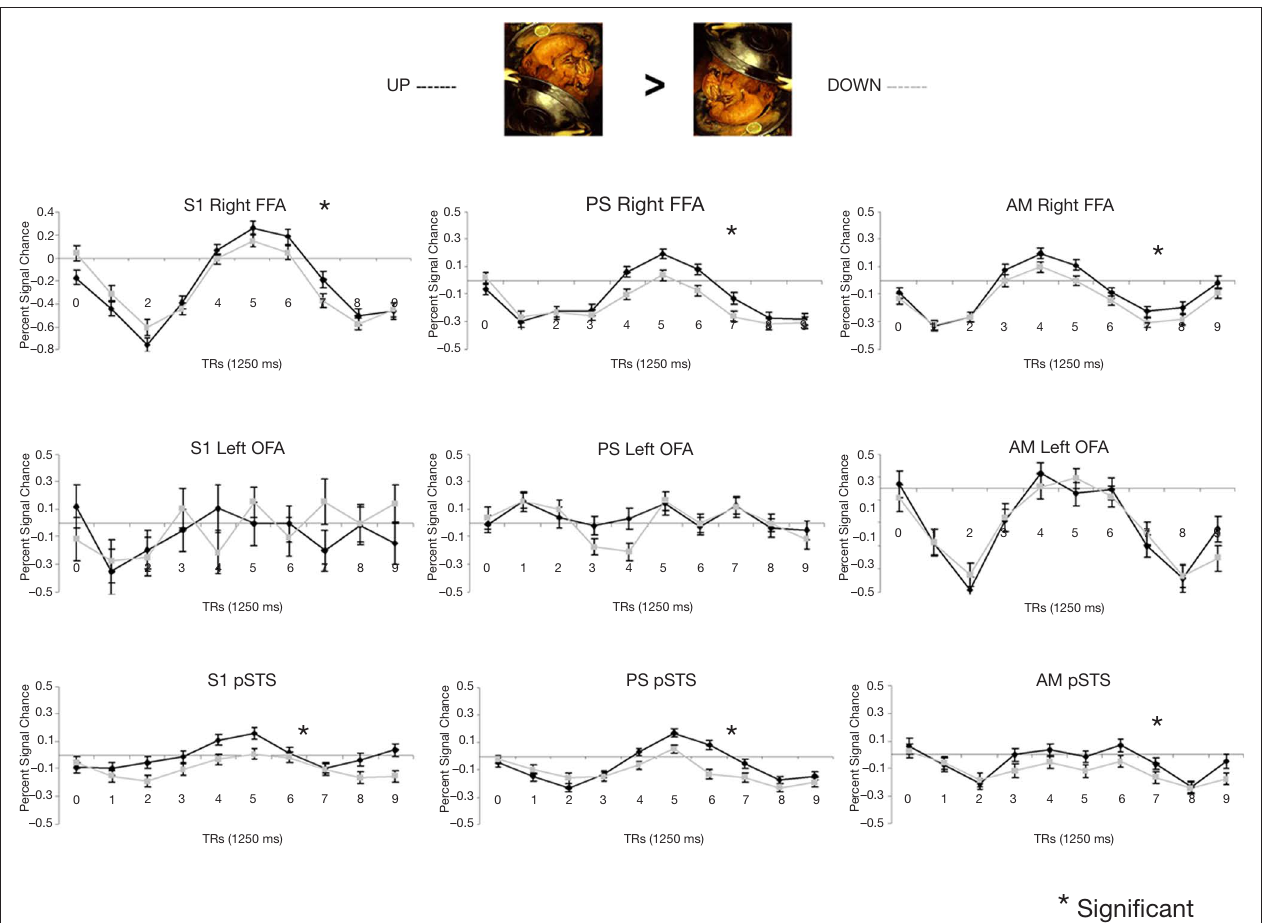
Figure 9 | Among the face-sensitive areas that are intact in the prosopagnosic patient’s brain, the right FFA, as well as the pSTS showed a larger response to Arcimboldo stimuli perceived as faces as compared to the same pictures presented upside-down (“non-faces”). Similar findings are made for control participants (here A1 illustrated), PS and the age-matched control